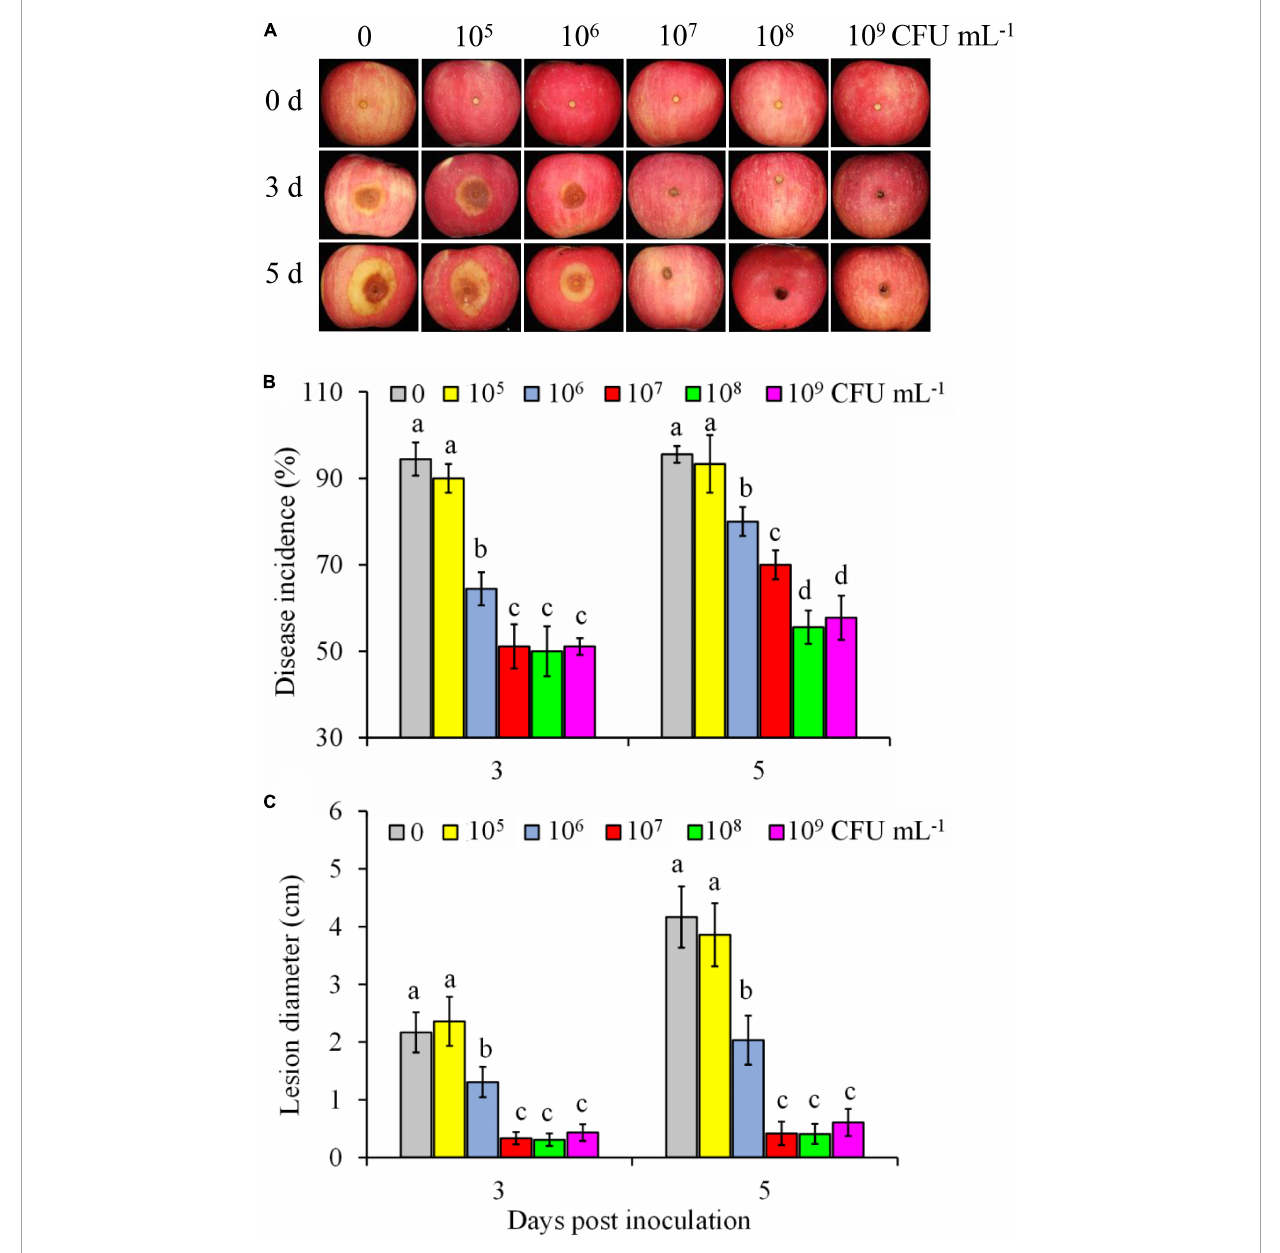
FIGURE1 Efficiency of P. syringae B-1 against B. dothidea in apple fruit. Disease symptoms (A) in control and strain B-1 treated fruit at 3 and 5 days post-inoculation (dpi) with B. dothidea . Effect of strain B-1 on disease incidence (B) and lesion diameter (C) in inoculated apple fruit at 3 and 5 dpi. Error bars represent the SD of three replicates. Different letters above the bars indicate significant differences ( p < 0.05) within the same panel at the same time